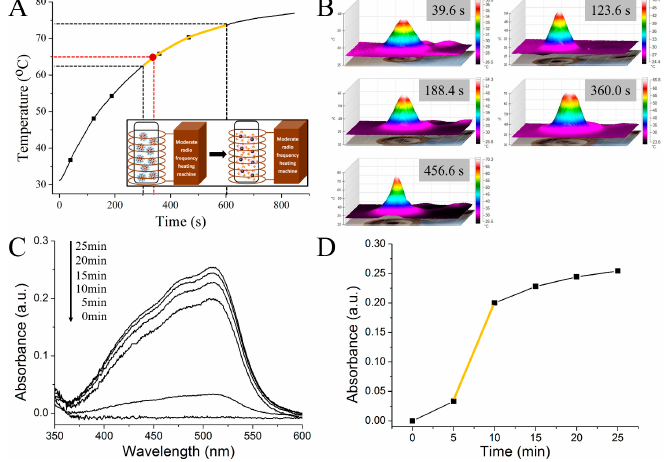
Figure 4. ( A ) Temperature vs. time curve of MMs; ( B ) Thermal images of MMs at time points in ( A ); ( C ) The orthophenanthroline spectrophotometry curves of iron elements in filtrates at time points; ( D ) The absorbance at 510 nm vs. time curve.